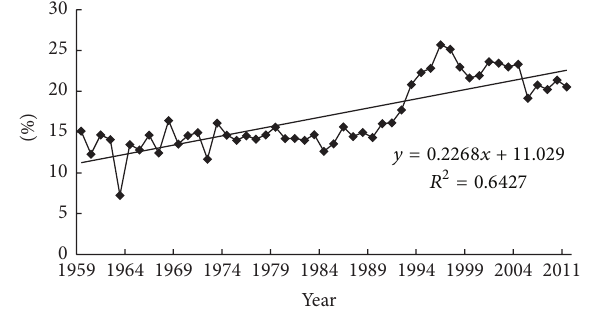
Figure 2: Tendency of flow partition ration of Sanshui.